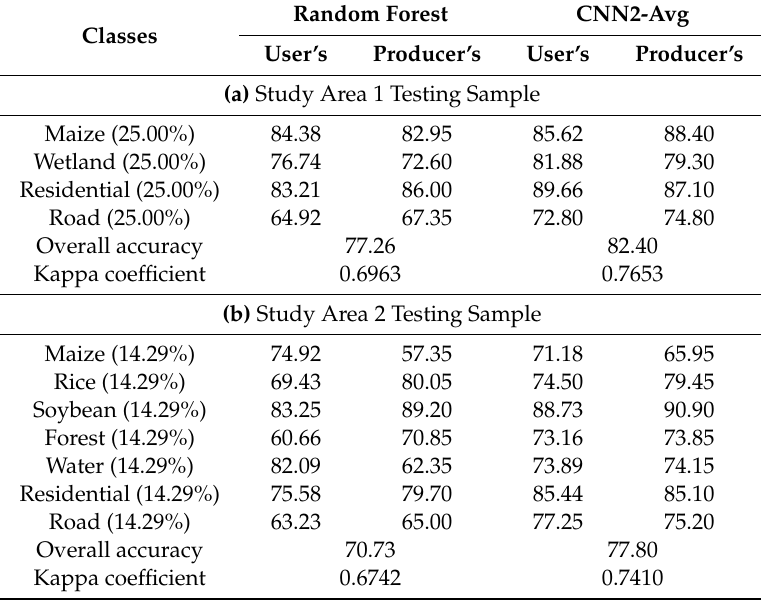
Table 6. Balanced sample accuracies of the random forest and the CNN2-Avg model for study areas 1–4 samples data. A total of 2000 training and 2000 testing samples were randomly selected from Table 3 (class with samples < 4000 was not used). The training sample percent to the total training samples (the value is same for the testing sample) is shown in the bracket after class name.